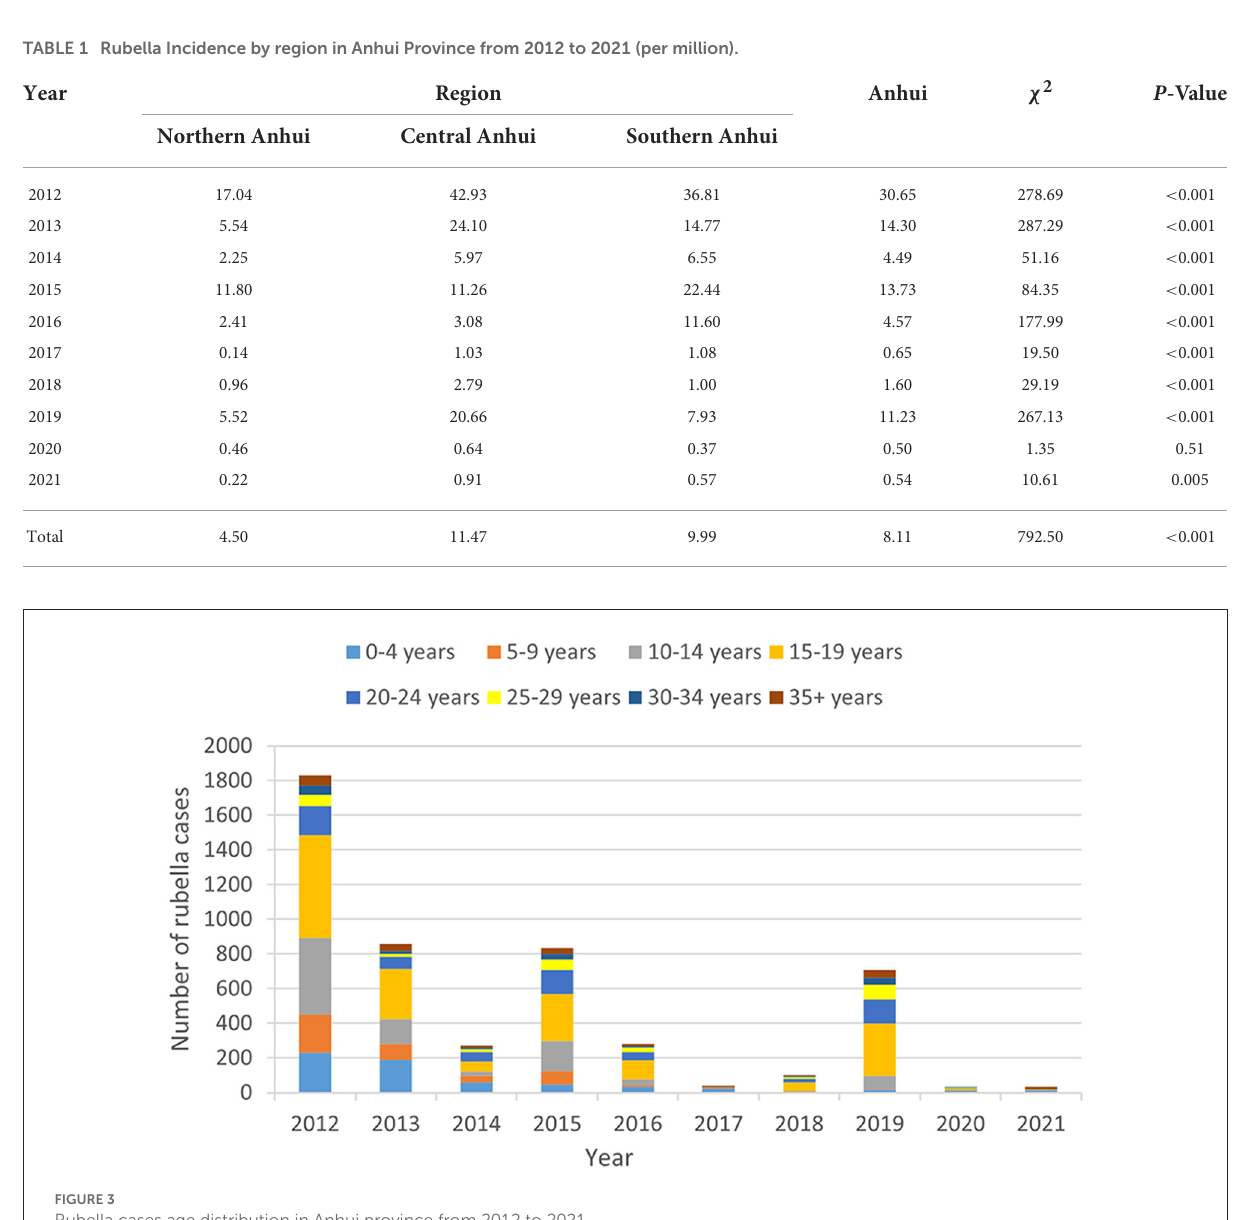
comparison of the incidence showed that the incidence of males and females were statistically significant in other 6 years except 2017, 2018, 2020, and 2021 (Table 2, Supplementary Table